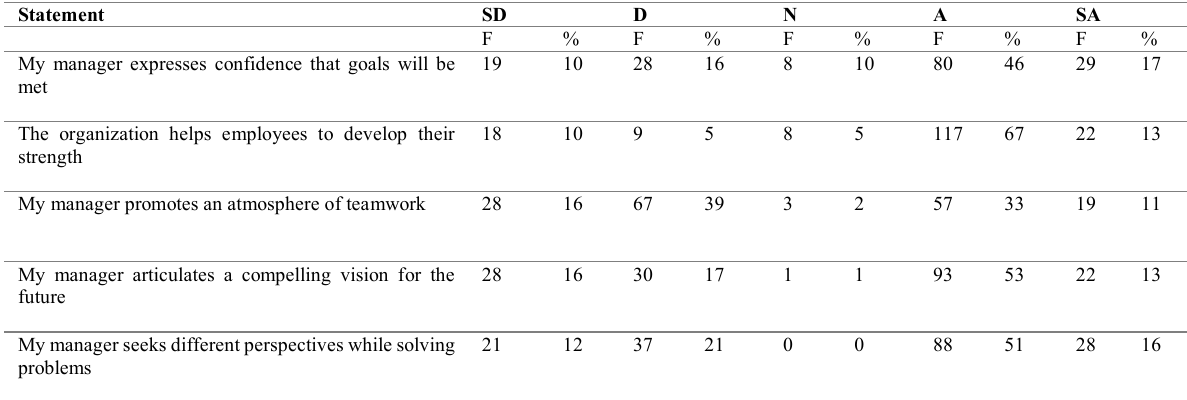
Table 2: Results for Transformational